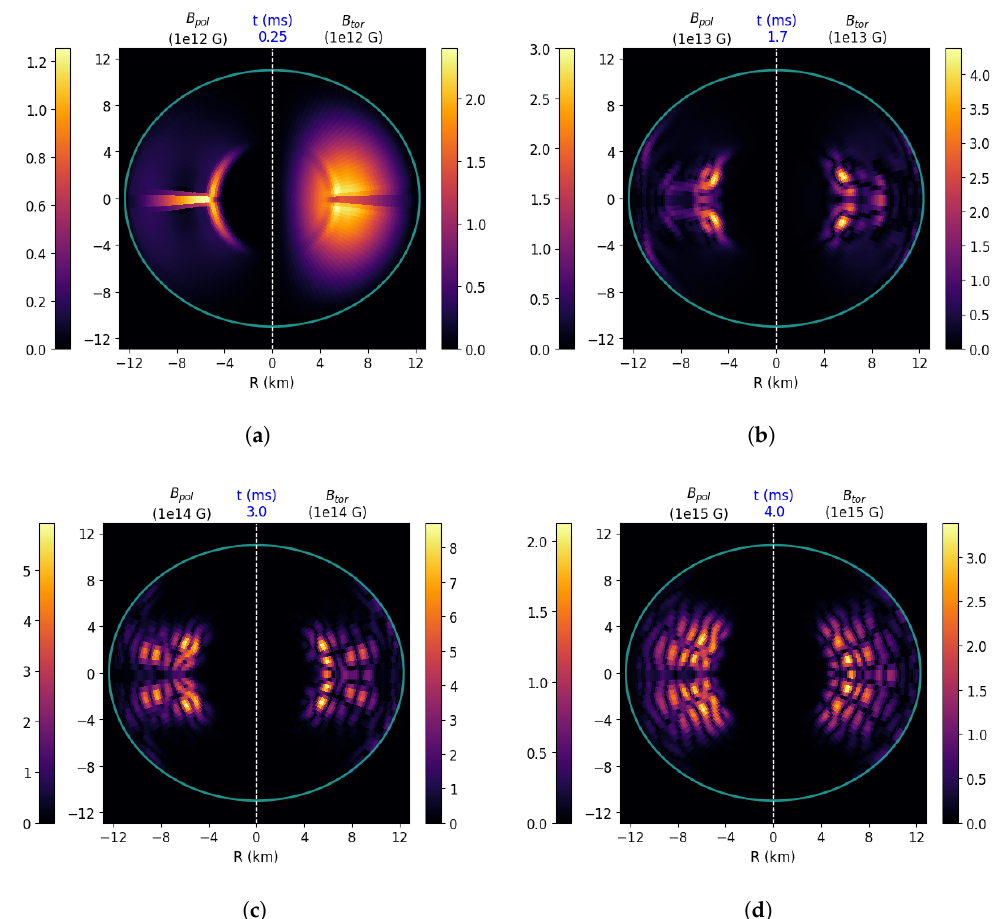
Figure 2. Color maps of the poloidal ( B pol , left side of each figure) and toroidal ( B tor , right side of each figure) components of the magnetic field at four different times for Run1. The blue solid curve is the surface of the star. In the colorbar, values are in order of ( a ) 10 12 G; ( b ) 10 13 G; ( c ) 10 14 G; ( d ) 10 15